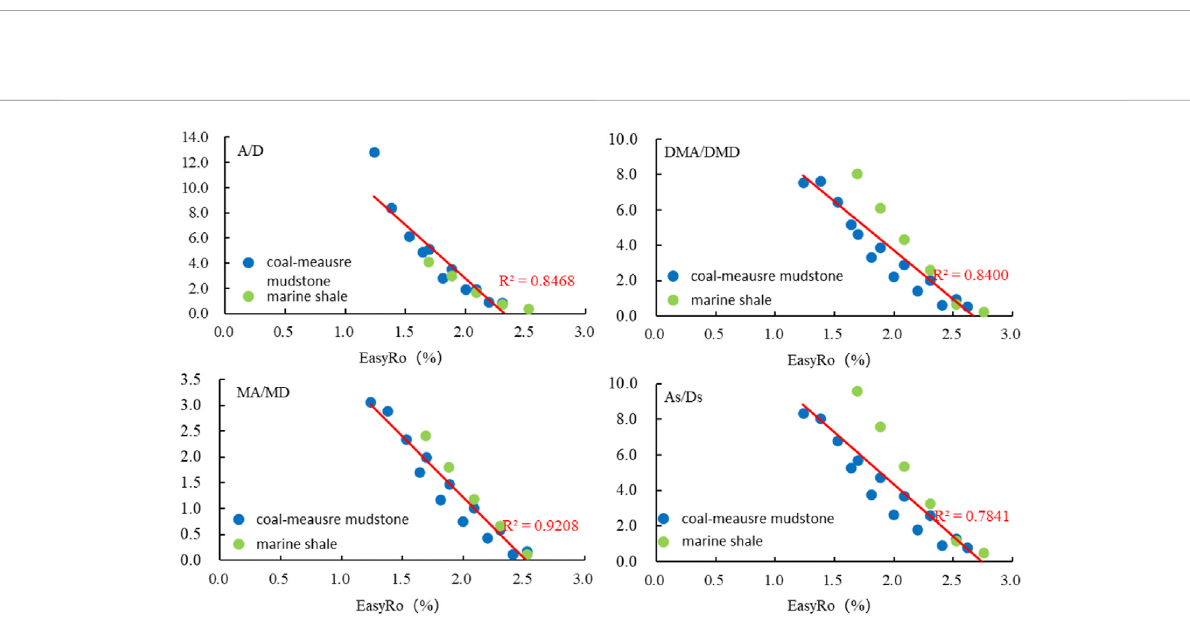
Change diagram of diamondoid parameters (MAI, EAI, TMAI-1) during marine shale (Fang et al., 2015b) and coal-measure mudstone pyrolysis.